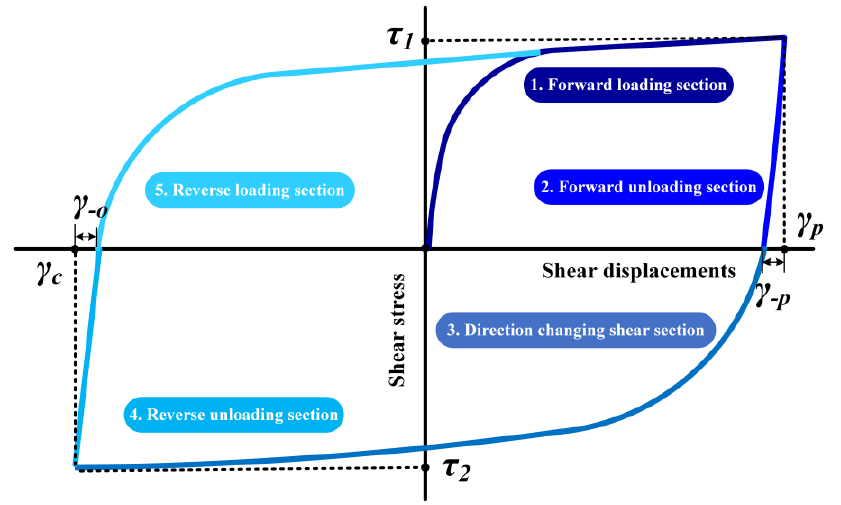
( c ) Figure 12. Curve for normal displacement – number of cycles under different conditions : ( a ) shear amplitude; ( b ) roughness; ( c ) water content. 3.3. Stress – Displacement Mathematical Model for Cyclic Shear Silt – Steel interface 3.3.1. Model Derivation